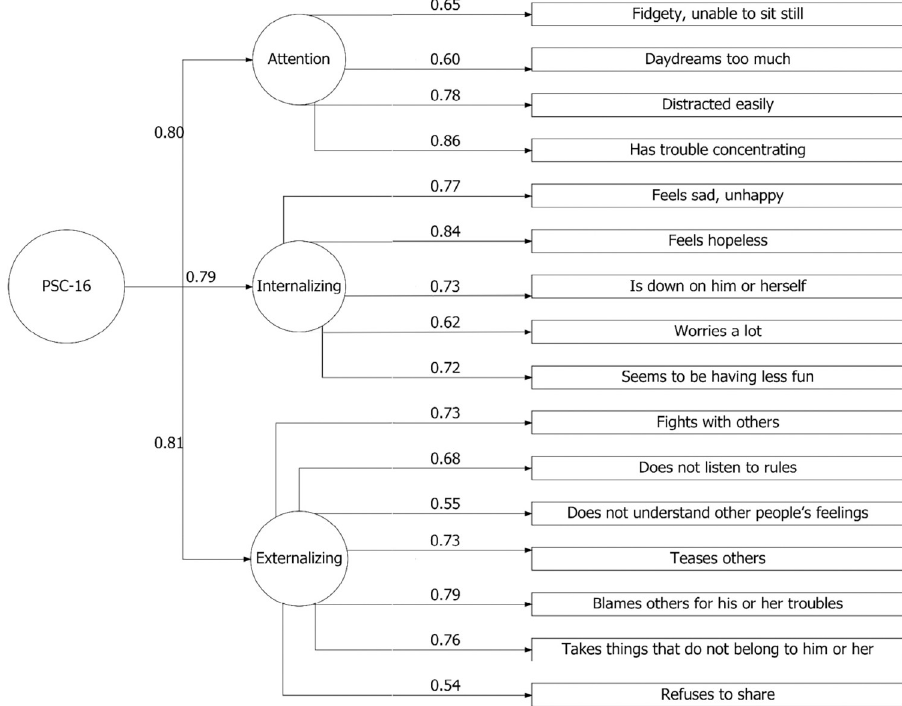
Fig 1. Confirmatory factor analysis of the PSC showing the three-factor